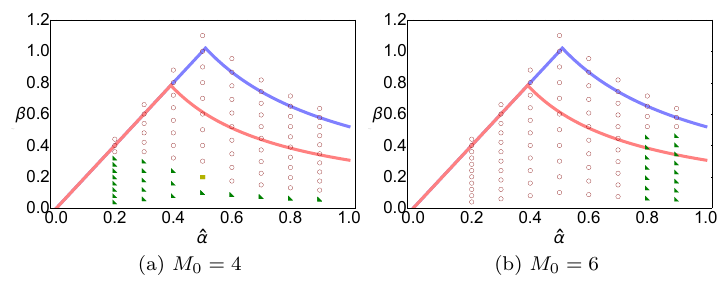
Figure 8. Practical stability analysis of the scheme S for β = 0 . 1 k (cid:98) β nec ( (cid:98) α,M 0 ), 1 ≤ k ≤ 11, in dependence on (cid:98) α , for M 0 = 4 , 6 and τ = (cid:98) αh/ ( | u | + c s )